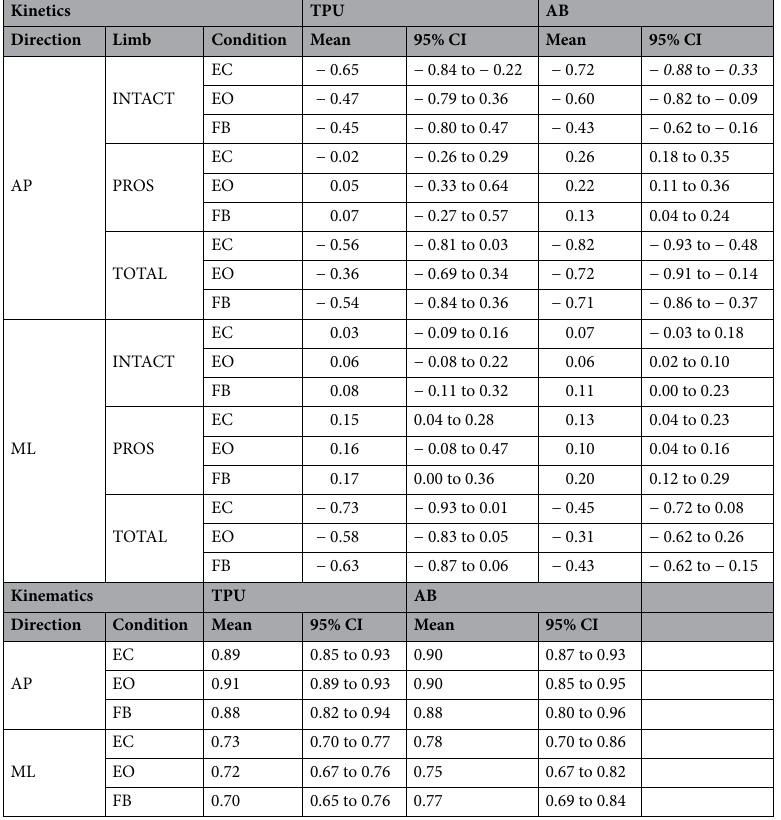
Table 2. Mean and 95% confidence intervals of the back-transformed correlation coefficients of the direction (AP = anteroposterior, ML = mediolateral), group (transtibial prosthesis users = TPU or able-bodied = AB), sensory conditions (eyes-open = EO, eyes-closed = EC, feedback = FB) and CoP under each limb (Limb) (PROS = constrained/prosthesis, INTACT = unconstrained/intact,